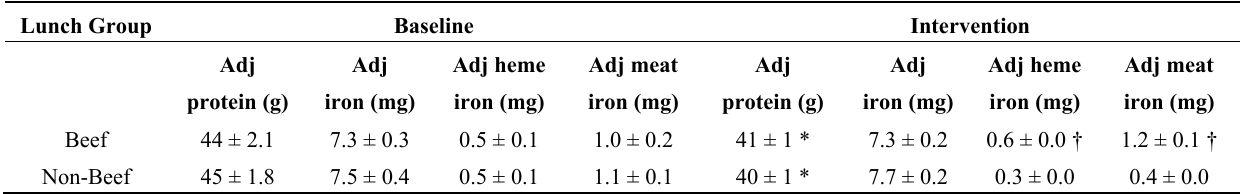
Table 6. Reported dietary intake for lunch